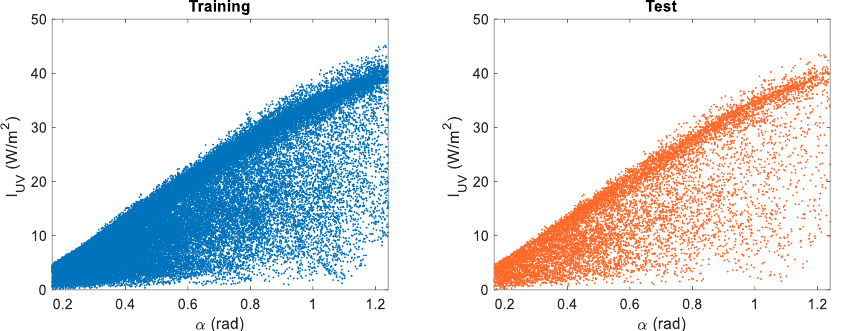
Figure 5. Ultraviolet irradiance, I UV , vs. solar altitude, α .